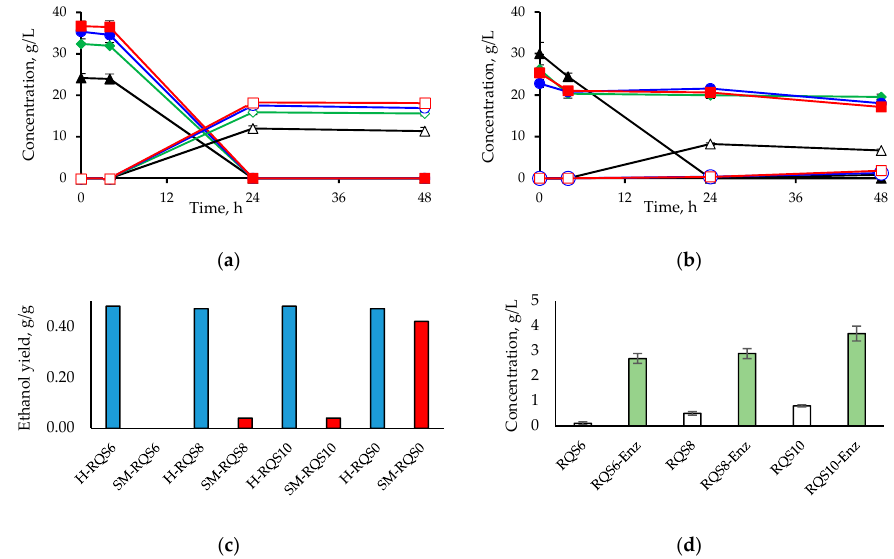
Figure 3. Concentration of glucose (filled symbols) and ethanol (open symbols) during fermentation of hydrolysates produced by enzymatic hydrolysis of SPS in presence of RQS ( a ) and synthetic media with directly-added RQS ( b ). RQS dosages: 6 g/100 g biomass (rhombs), 8 g/100 g biomass (circles), 10 g/100 g biomass (squares), RQS-free control (triangles). Ethanol yield in the fermentations of hydrolysates (blue bars) and synthetic media (red bars) ( c ). Final glucose concentration after incubation of RQS with (green bars) and without (white bars) cellulases ( d ). RQS concentrations in the synthetic media are equivalent to the dosages used in hydrolysis. Mean of three replicates. The error bars correspond to standard deviations.